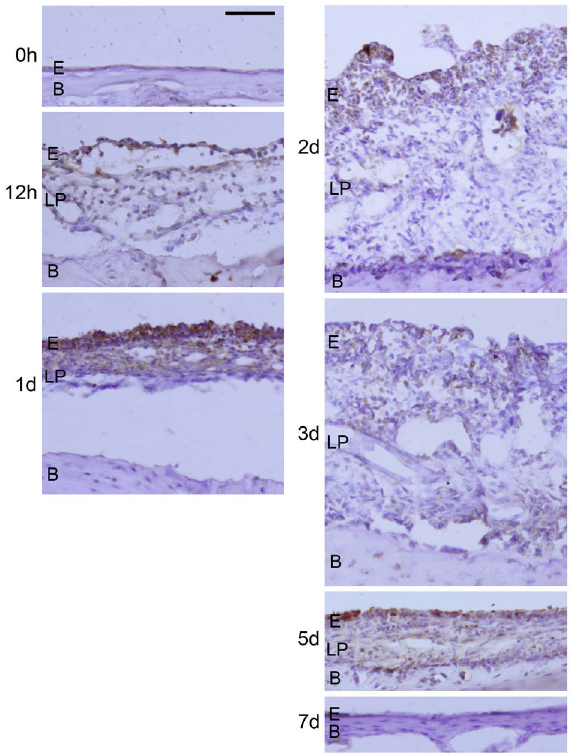
Figure 5. Immunohistochemistry of HB-EGF in the ME mucosa during OM. Frozen sections of the rat ME were immunostained with a primary antibody directed against HB-EGF. Sections of uninfected ME mucosa (0 h) and infected ME mucosa (12 h, 24 h, 2d, 3d, 5d or 7d after infection) were processed. Positive reaction product (brown) was observed from 12 h to 5d postinoculation. Labeling was observed primarily in the epithelial layer of ME mucosa and in scattered leukocytes within the tissue or within the ME lumen. E: epithelial layer, LP: lamina propria, B: bone of ME bulla. Scale bar represents 100 m m.